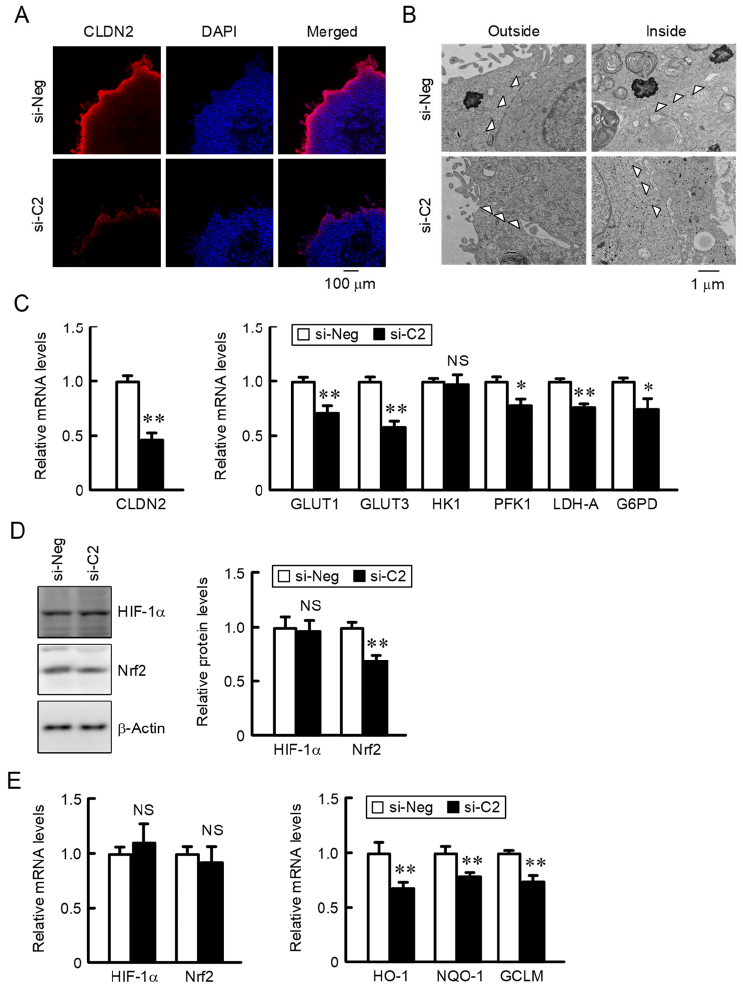
Figure 3. Decrease in glucose transporters and metabolic enzymes by CLDN2 knockdown in 3D spheroid cells. A549 cells transfected with negative (si ‐ Neg) or CLDN2 siRNA (si ‐ C2) were cultured in 96 ‐ well round ‐ bottomed plates for 4 days. ( A ) The localization of CLDN2 protein (red) was examined using confocal laser microscopy. The nuclei are stained with DAPI (blue). ( B ) The structure of the tight junction was observed by transmission electron microscope. The kissing points are indicated as arrowheads. ( C , E ) Real ‐ time PCR was performed using primer pairs as listed in Table 1. The mRNA levels are represented relative to the values in si ‐ Neg. ( D ) Western blotting was performed using anti ‐ HIF ‐ 1 α , anti ‐ Nrf2 and anti ‐β‐ actin antibodies. The protein levels are represented relative to the values in si ‐ Neg. n = 3–4. ** p < 0.01 and * p < 0.05 compared with si ‐ Neg. NS, p > 0.05.